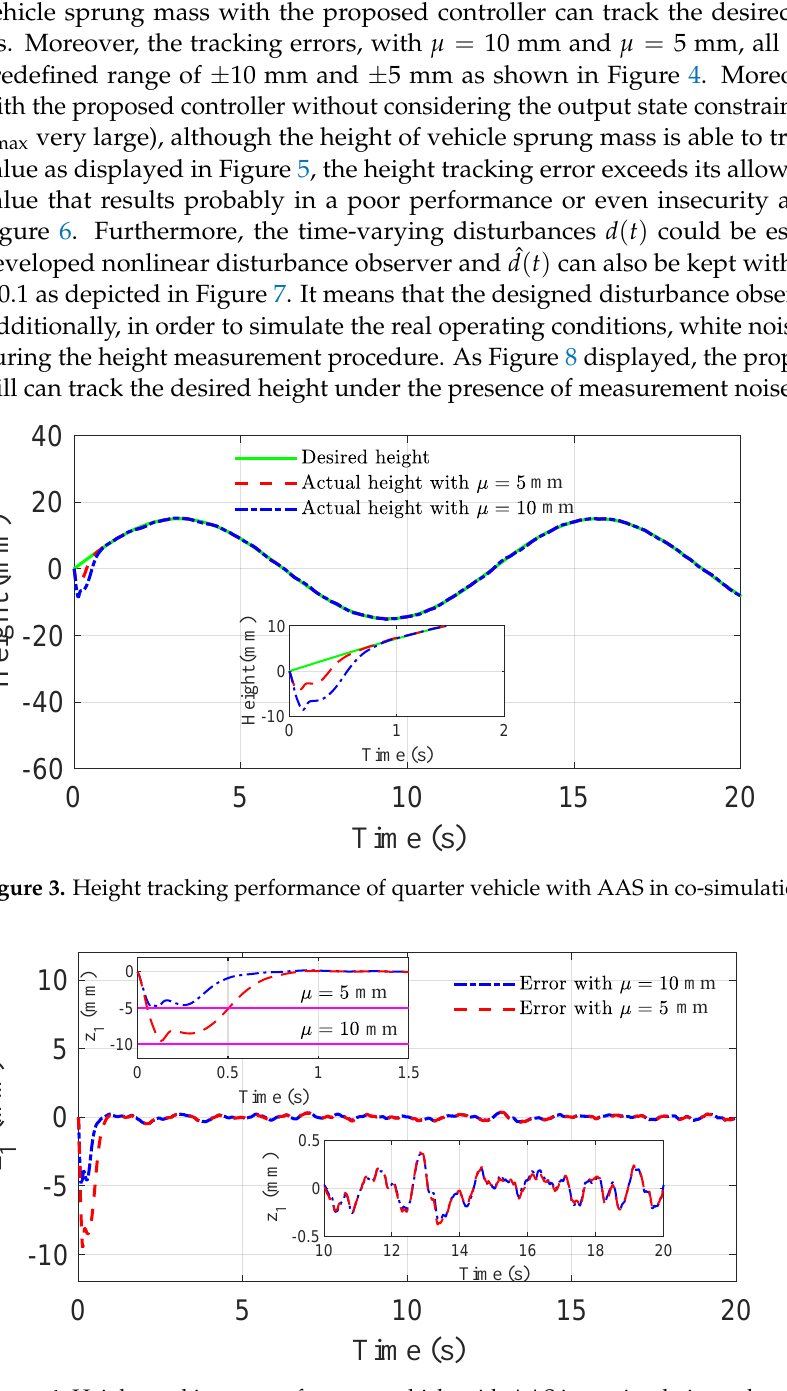
Figure 4. Height tracking error of quarter vehicle with AAS in co-simulation, where | z 1 | always stays within its corresponding